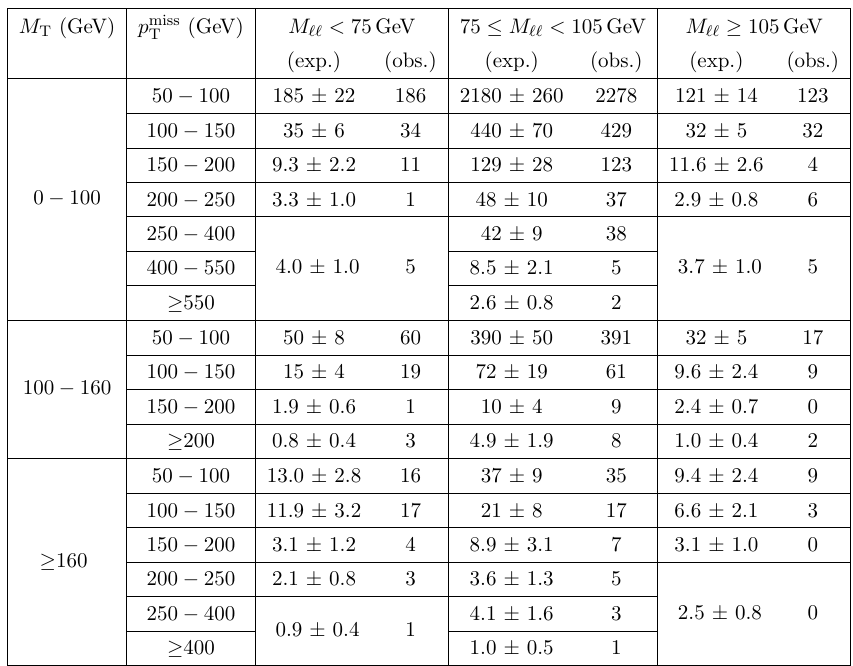
Table 12 . Category A: expected and observed yields in events with three e or (cid:22) that form at least one OSSF pair. For each bin, the (cid:12)rst number corresponds to the expected yield (exp.) and its uncertainty, and the second denotes the observed yield (obs.). The uncertainty denotes the total uncertainty in the yield.